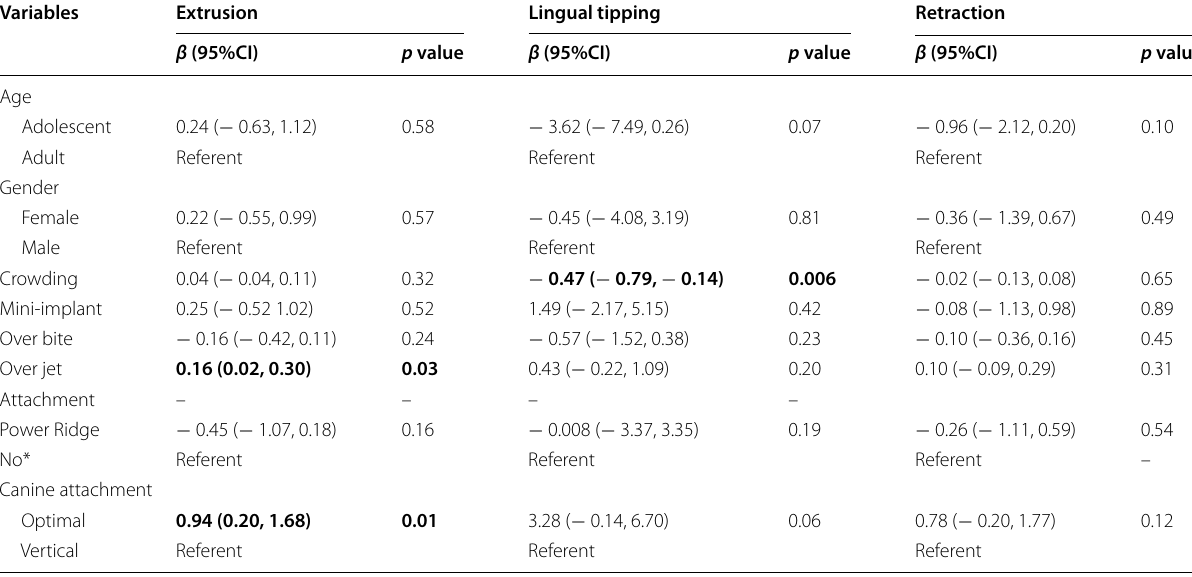
Bold values indicate statistical significance ( p < 0.05) Result from the multiple linear regression analysis for actual tooth movement of central incisors p value and 95% confidence interval (CI) ranges of the coefficient for each variable. The coefficient ( β ) presents the effect strength of the respective factor. p value below 0.05 was considered as statistical significance